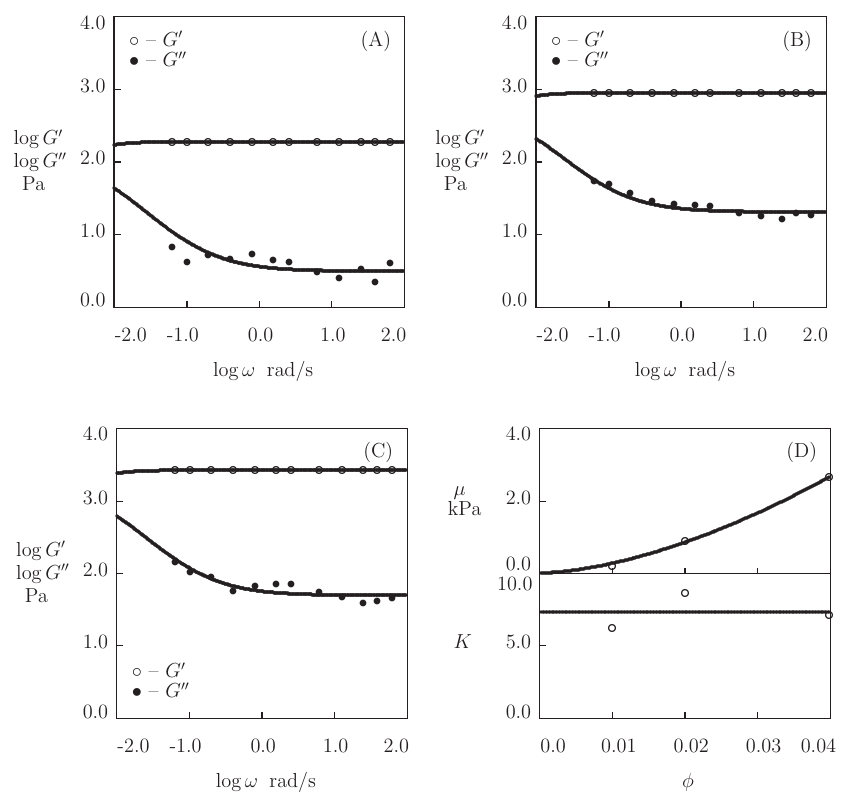
Figure 5. ( A – C )–Storage modulus G (cid:48) and loss modulus G (cid:48)(cid:48) versus frequency ω . Symbols: exper- imental data [69] on HA gels that were cross-linked by hydrazine-aldehyde complexation with φ cat = 50 mM and various mass fractions of HA φ (( A )– φ = 0.01, ( B )– φ = 0.02, ( C )– φ = 0.04). Solid lines: the results of simulation. ( D )–Parameters µ and K versus mass fraction φ of HA. Circles: treatment of observations. Solid lines: the results of